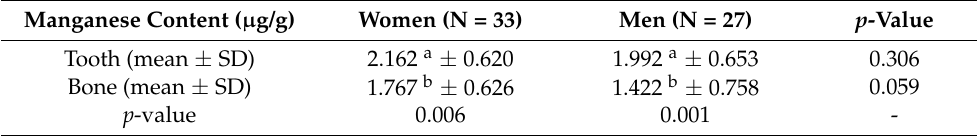
Table 25. Manganese content in tested samples taken from patients of different sexes.